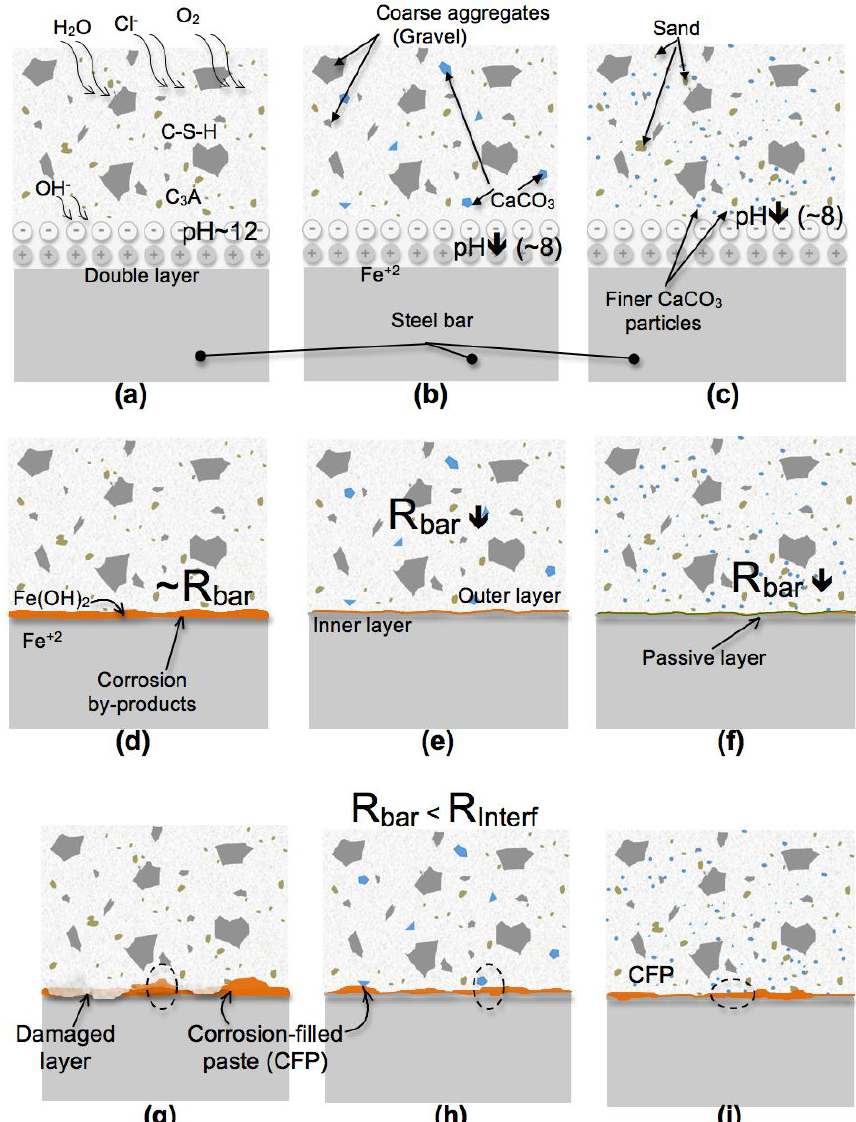
Figure 9. Schematic representation involving of the three distinct concretes: ( a ) the conventional concrete sample (CC), ( b , c ) the SAND and the CEM samples the SAND sample containing 10 wt.% EG particles, respectively, at initial stages of immersion. ( d – f ) sequential stages of immersion (e.g., 7 days) with evolution of double layer to corrosion (film) layer and interaction with bar, and ( g – i ) the relative long-term (~365 days) immersion with possible damaged oxide layer and corresponding corrosion-filled (CFP) paste.